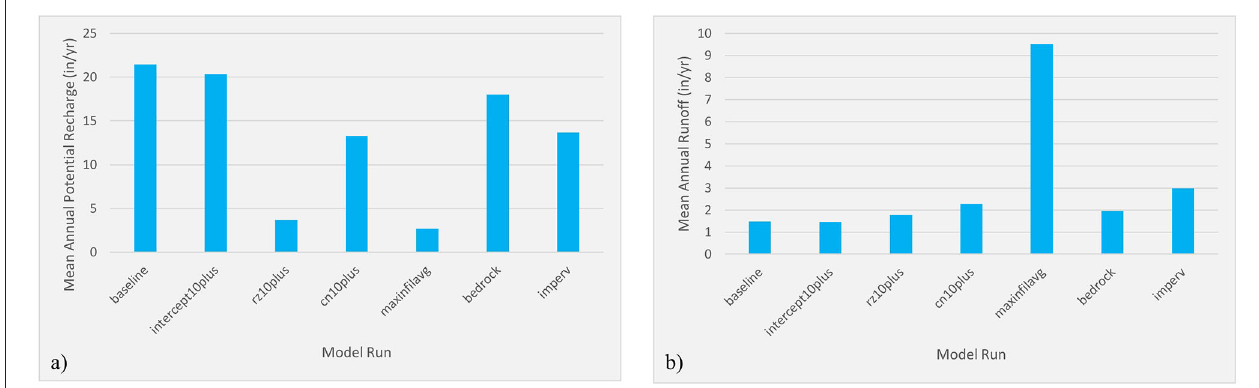
FIGURE 9 | Sensitivity of model parameters to modeled (a) recharge (b) runoff. See text for description of model